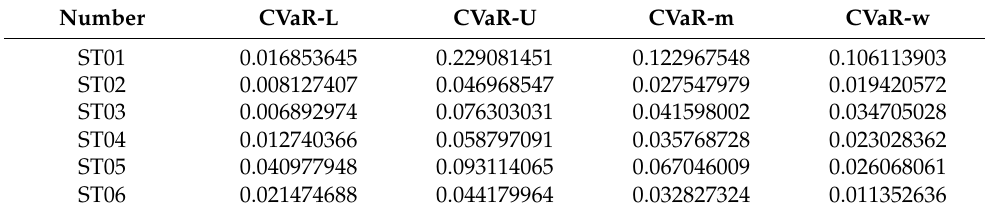
Table 10. ICVaR, data from international